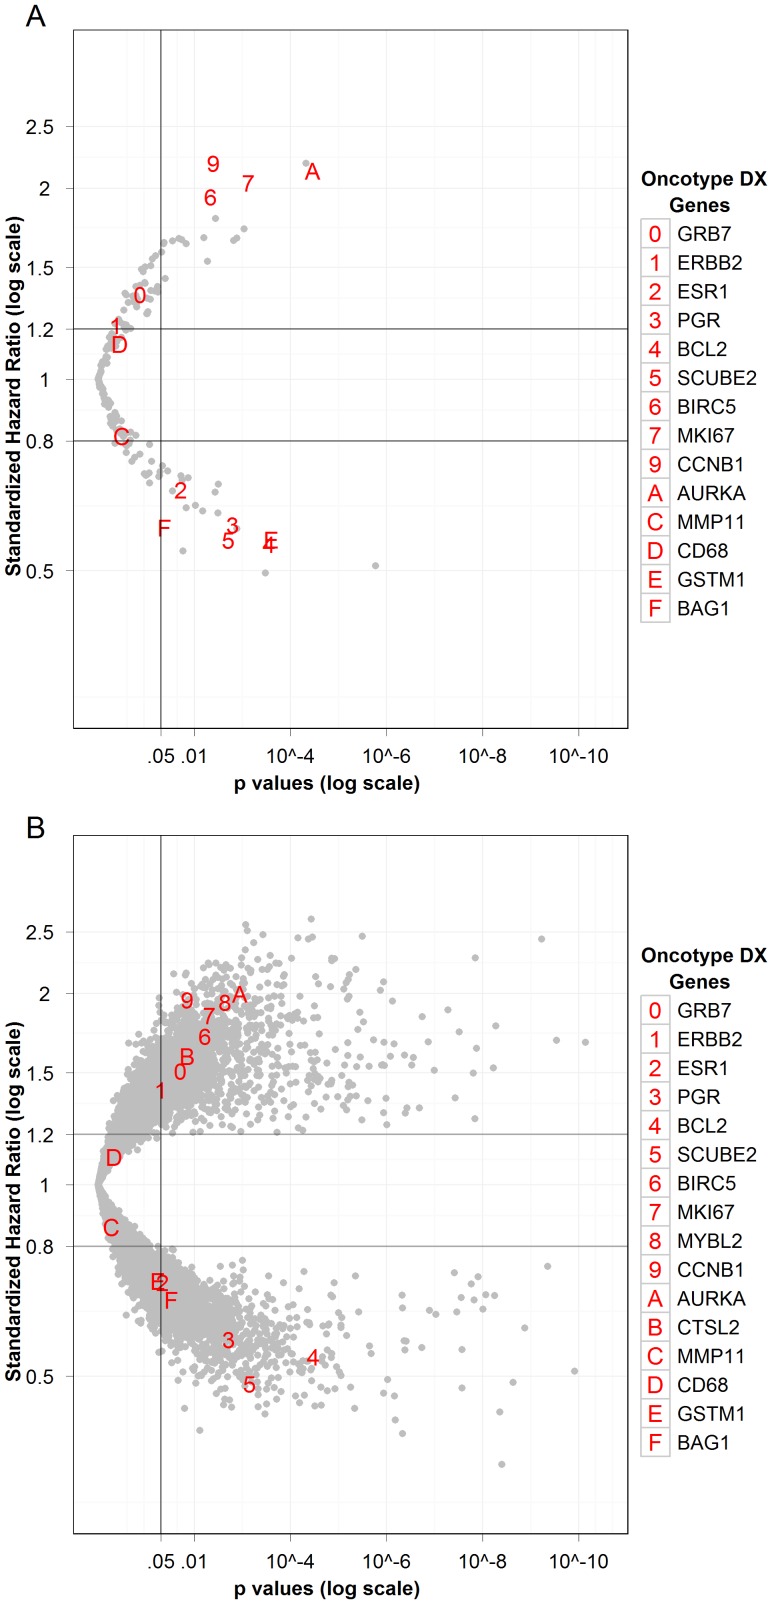
Relationship of increased RNA expression to risk of breast cancer recurrence in 136 breast cancer patients.Each point represents a distinct RNA. The magnitude of the effect size is given by the hazard ratio from Cox proportional hazard analysis and statistical significance by P-Value. Genes in the 21-gene breast cancer recurrence risk assay are marked with alphanumeric symbols. A. Analysis of 192 genes measured by RT-PCR. B. Analysis of assembled RefSeq transcripts as measured by whole transcriptome RNA-Seq.